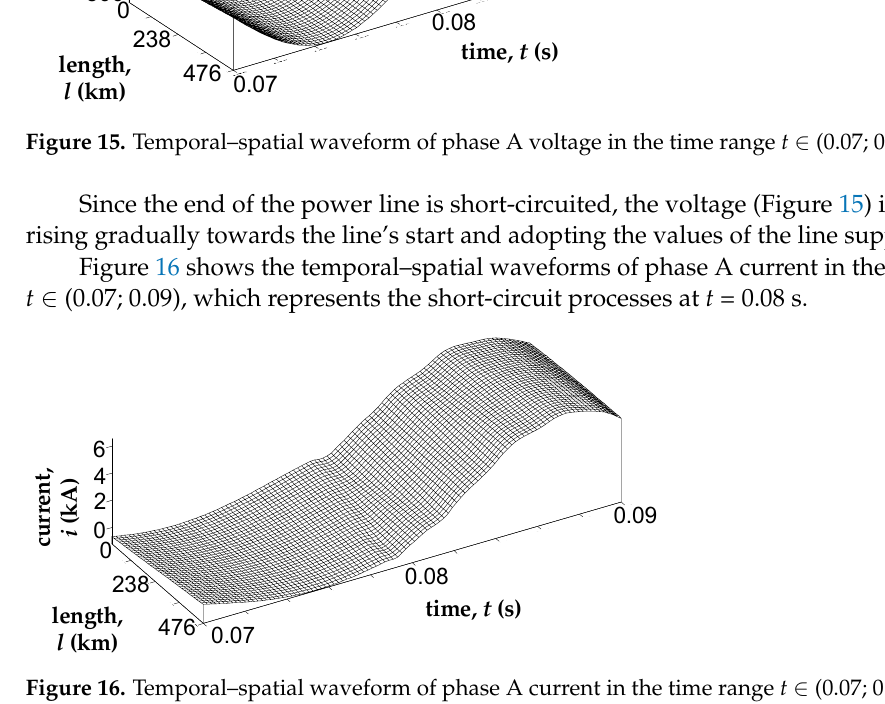
Figure 16. Temporal–spatial waveform of phase A current in the time range t ∈ (0.07; 0.09) s.